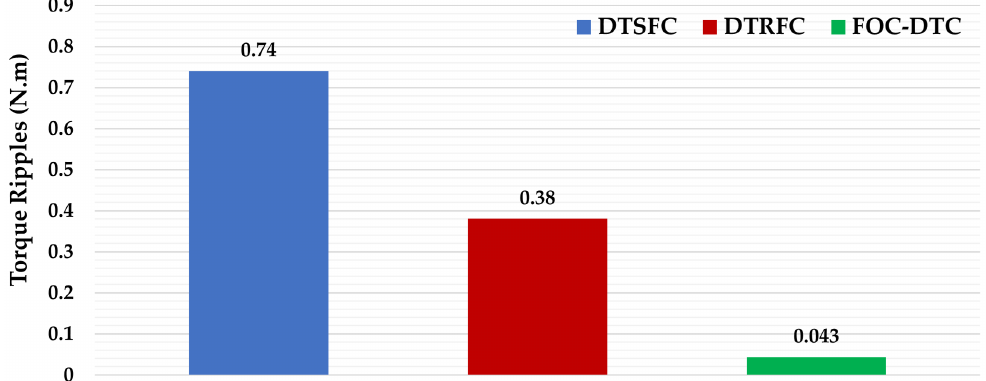
Figure 38. Comparisons of torque ripples for DTSFC, DTRFC, and the proposed FOC-DTC.